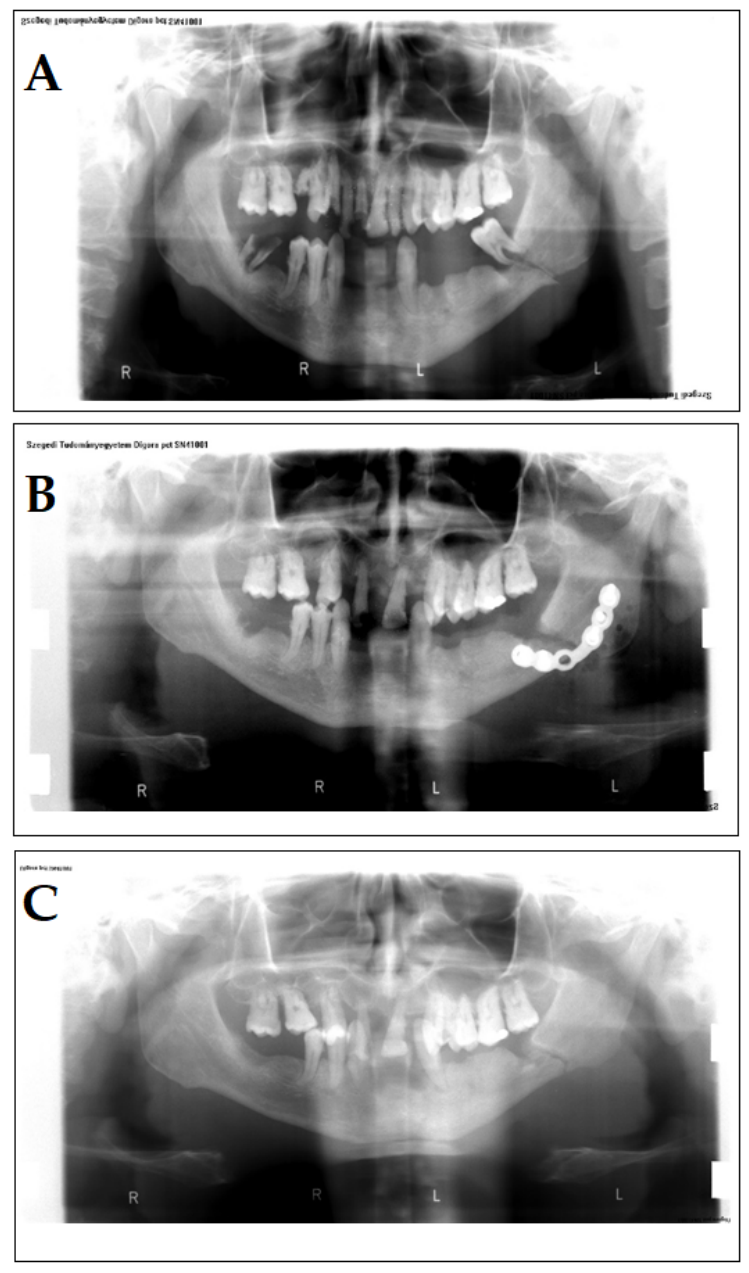
Figure 2. Panoramic X-rays of the patient in Case 2. A: Initial status of the patient, lower left molar in the fracture. B: Osteosynthesis with Leibinger-plate. C: Following the removal of the Leibinger-plate, during the healing period . Table 1 . Antimicrobial susceptibility testing results for strict anaerobes in Cases 1 and 2.